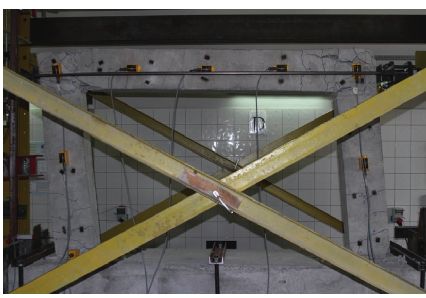
Figure 6: Picture of the frame loaded to 4% drift